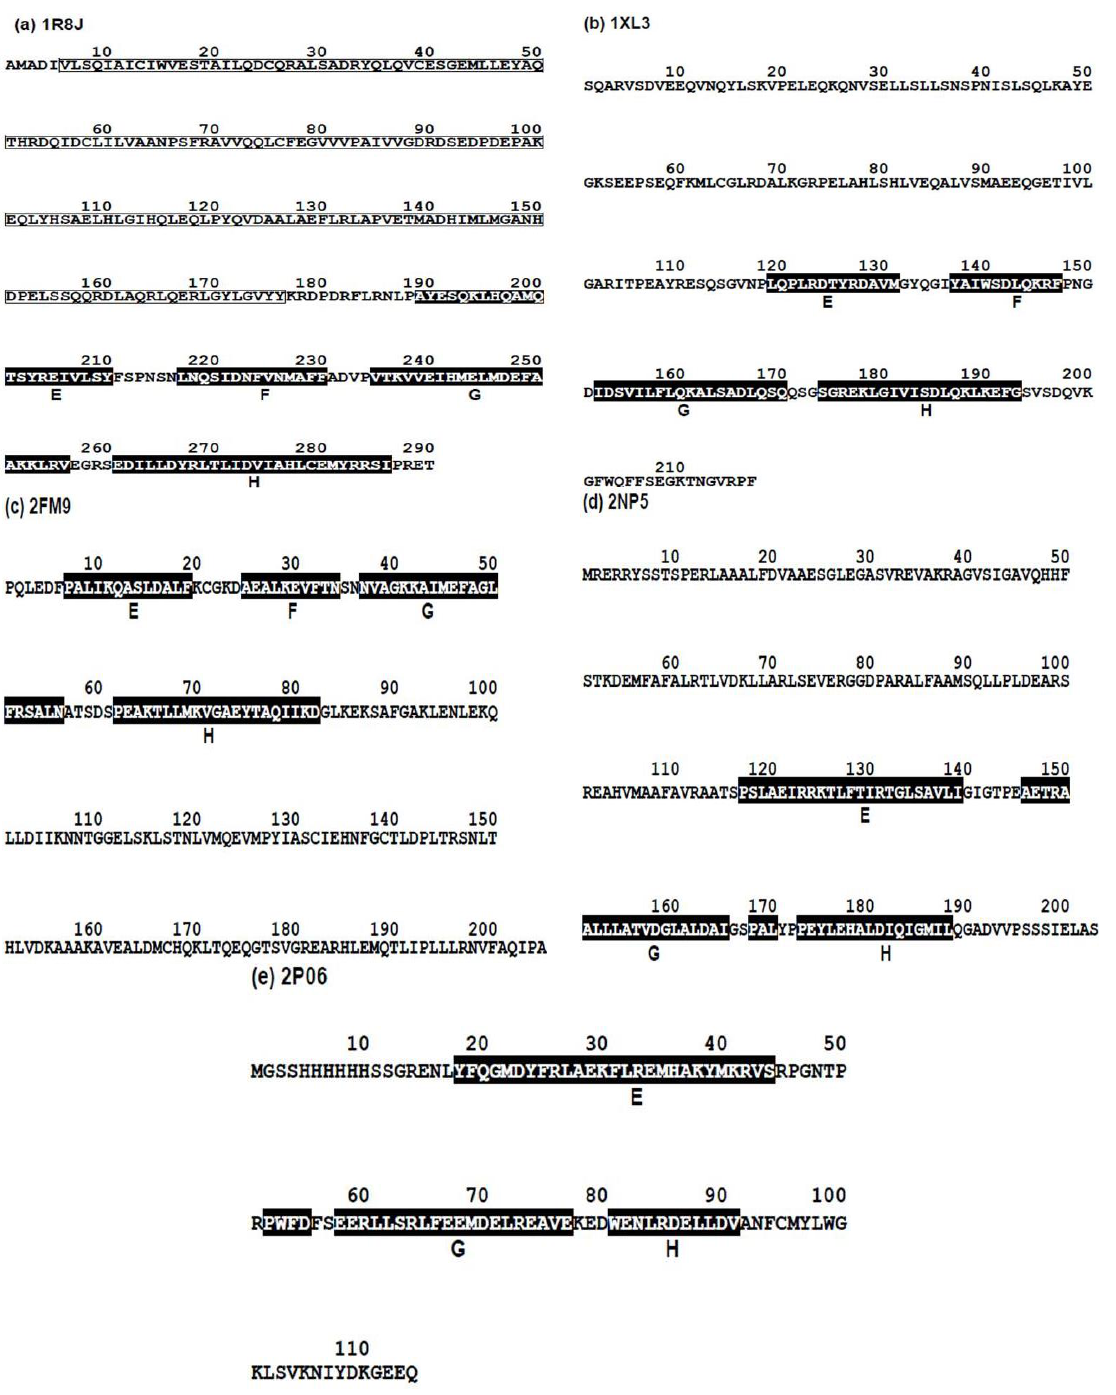
Figure 5. The amino acid sequences from FASTA files of ( a ) Circadian clock protein KaiA (Synechococcus, PDBID:1R8J), ( b ) Secretion control protein A chain (Yersinia, 1XL3), ( c ) Cell invasion protein SipA (Salmonella, PDBID: 2FM9), ( d ) Transcriptional regulator RHA1_ro04179 (Rodococcus, PDBID: 2NP5), and ( e ) Hypothetical protein AF0060 ( E. coli , PDBID: 2P06). White letters with a black background denotes a residue in the  -helices of the corresponding E-to-H helix